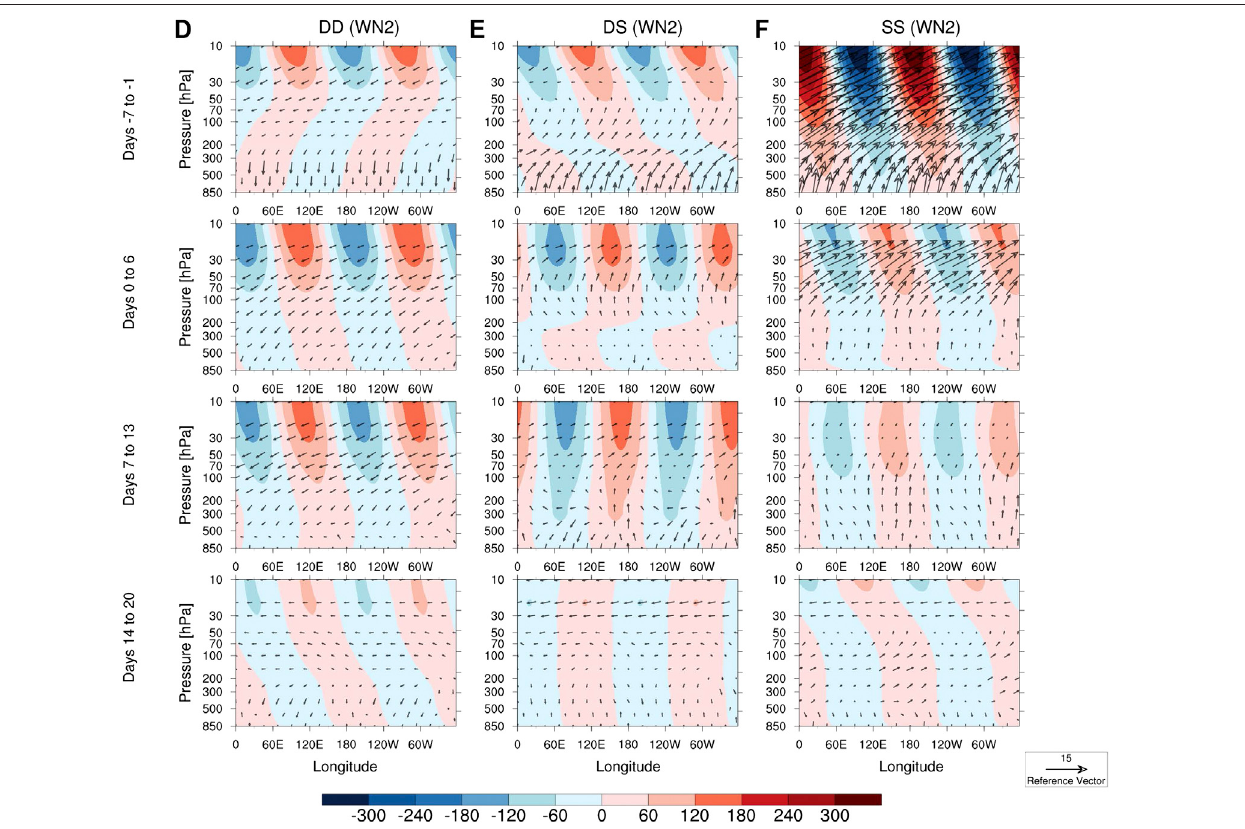
FIGURE 4 | (A) – (C) Longitude-height sections of geopotential height anomaly (shading) averaged over 60 ° N – 70 ° N, and zonal and vertical components of the 3-D waveactivity fl ux anomaly(arrows) averaged over 50 ° N – 60 ° N, calculated from wave 1component.From thetop tobottom, each panel shows theresults averagedover 7 days from days -7 to 20. The color interval is 100 m. Arrows at the bottom right indicate the magnitude of the zonal and vertical components of 3-D wave activity fl ux [m 2 s- 2 ]. The 3-D wave activity fl ux is scaled by level. (A) DD; (B) DS; and (C) SS SSW types. (D) – (F) As in (A) – (C) but for wave 2